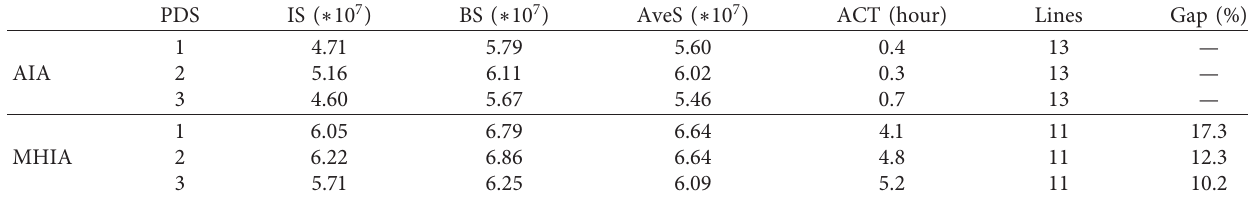
Table 9: Comparison between AIA and MHIA on the large HSR network.